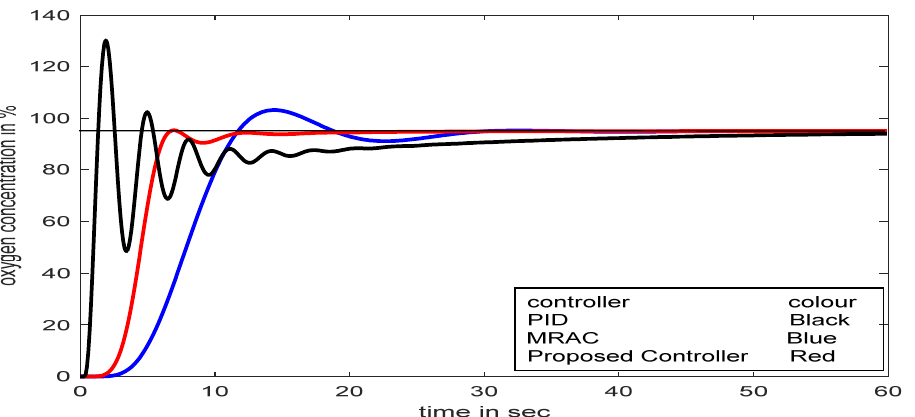
Figure 16. Comparative studies between PID, MRAC, and SFPIMRAC with set-point at 95% SpO 2 .